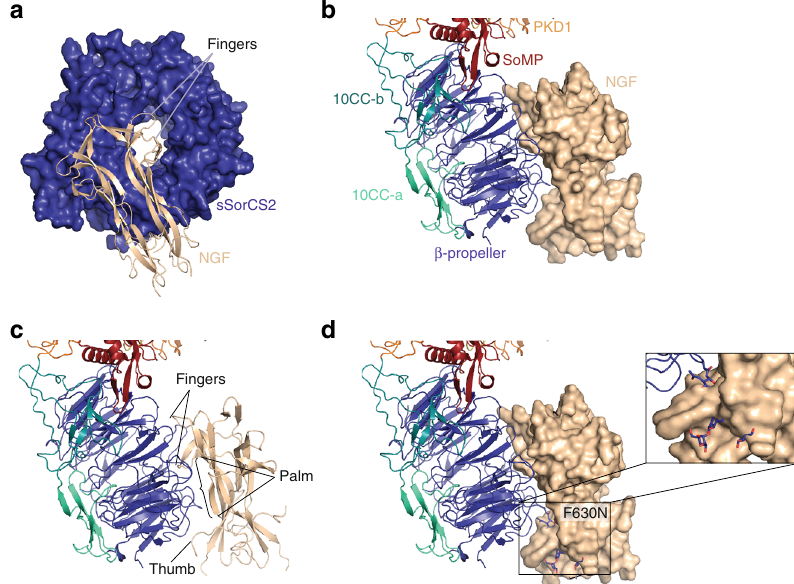
Fig. 3 The NGF – sSorCS2 interaction resembles a hand holding a tire. a NGF (cartoon representation, beige) interacts with the top face of the sSorCS2 β - propeller (surface representation, blue) that resembles a tire. For clarity only the sSorCS2 β -propeller and NGF are shown. The two NGF fi ngers (formed by β -strands A ′ and A ′′ and the loop connecting strands C and D) are positioned above the central β -propeller tunnel. b , c The NGF fi ngers, palm, and thumb are indicated. SSorCS2 in cartoon representation, colored according to Fig. 1a. NGF in surface representation in ( b ) and cartoon representation in ( c ). d Location of the F630N mutation and model of how the introduced oligomannose would interfere with NGF binding